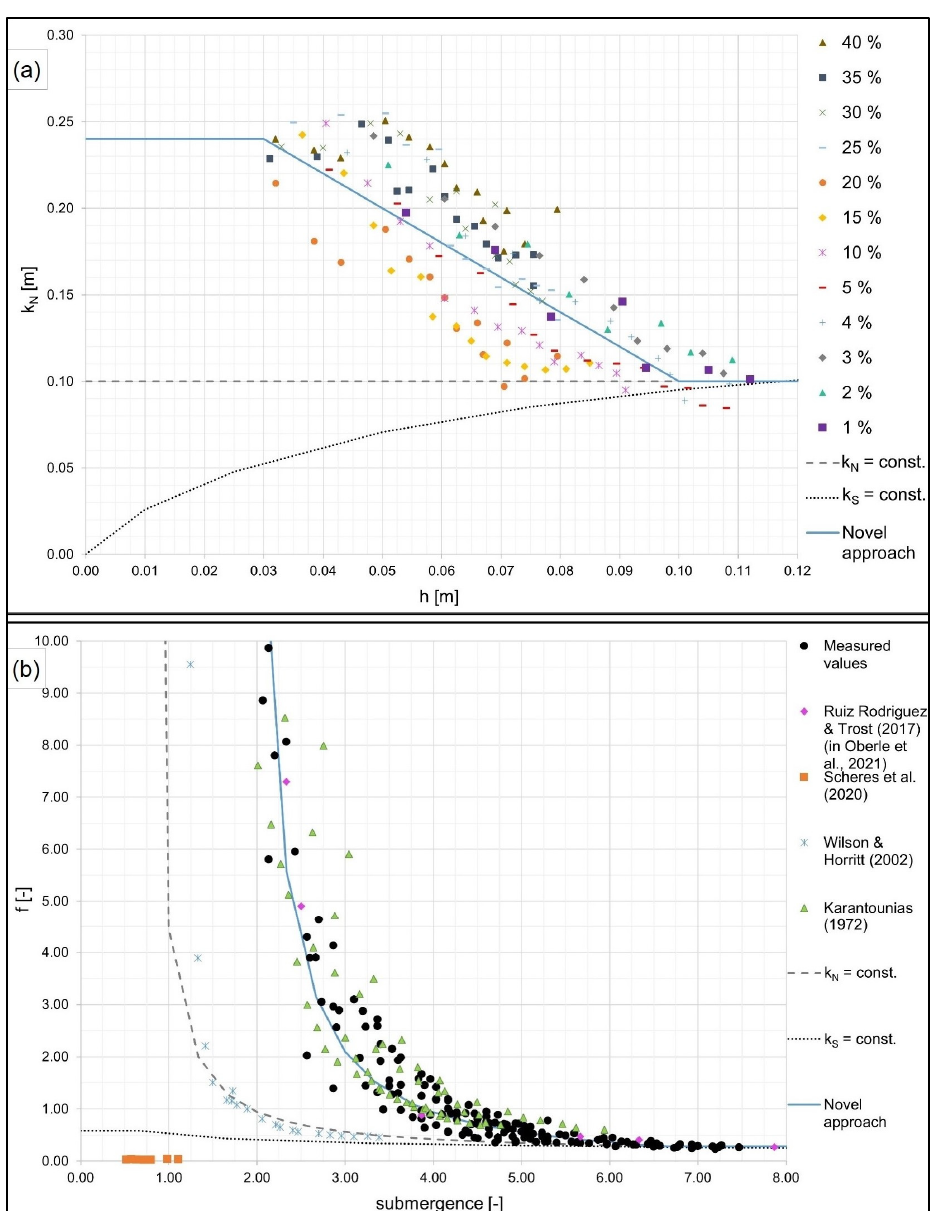
Figure 5. Relationship between water depth or submergence and roughness parameters: ( a ) water depth h against equivalent sand–grain roughness k N with courses of the novel approach (Equation (4)), a constant k N and a constant k S in comparison to measured values of this study (dots, separately for each slope condition) and ( b ) submergence against friction factor f with courses of the novel approach (Equation (4)), a constant k N and a constant k S in comparison to measured values of this study (black dots) and data from the literature.